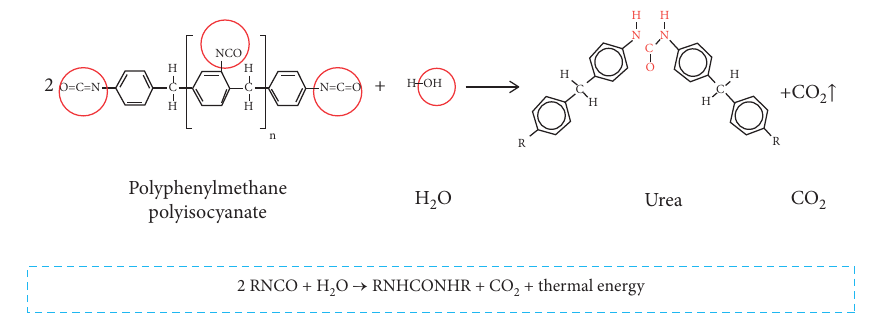
Figure 4: Principle of foaming reaction.